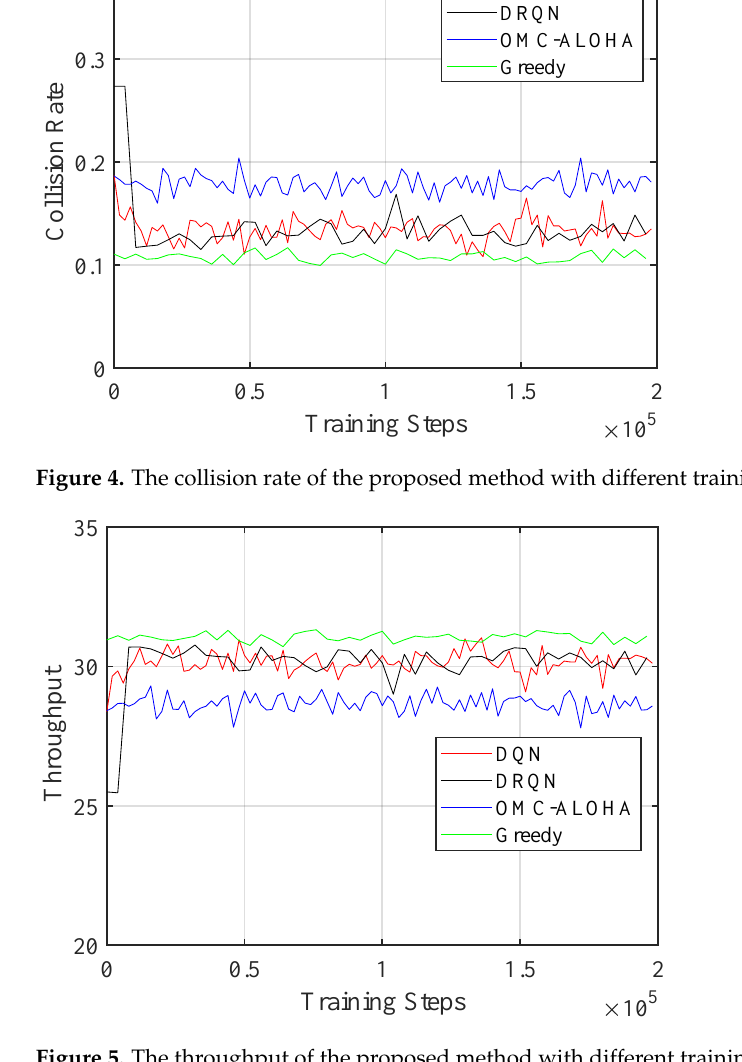
Figure 5. The throughput of the proposed method with different training steps (single